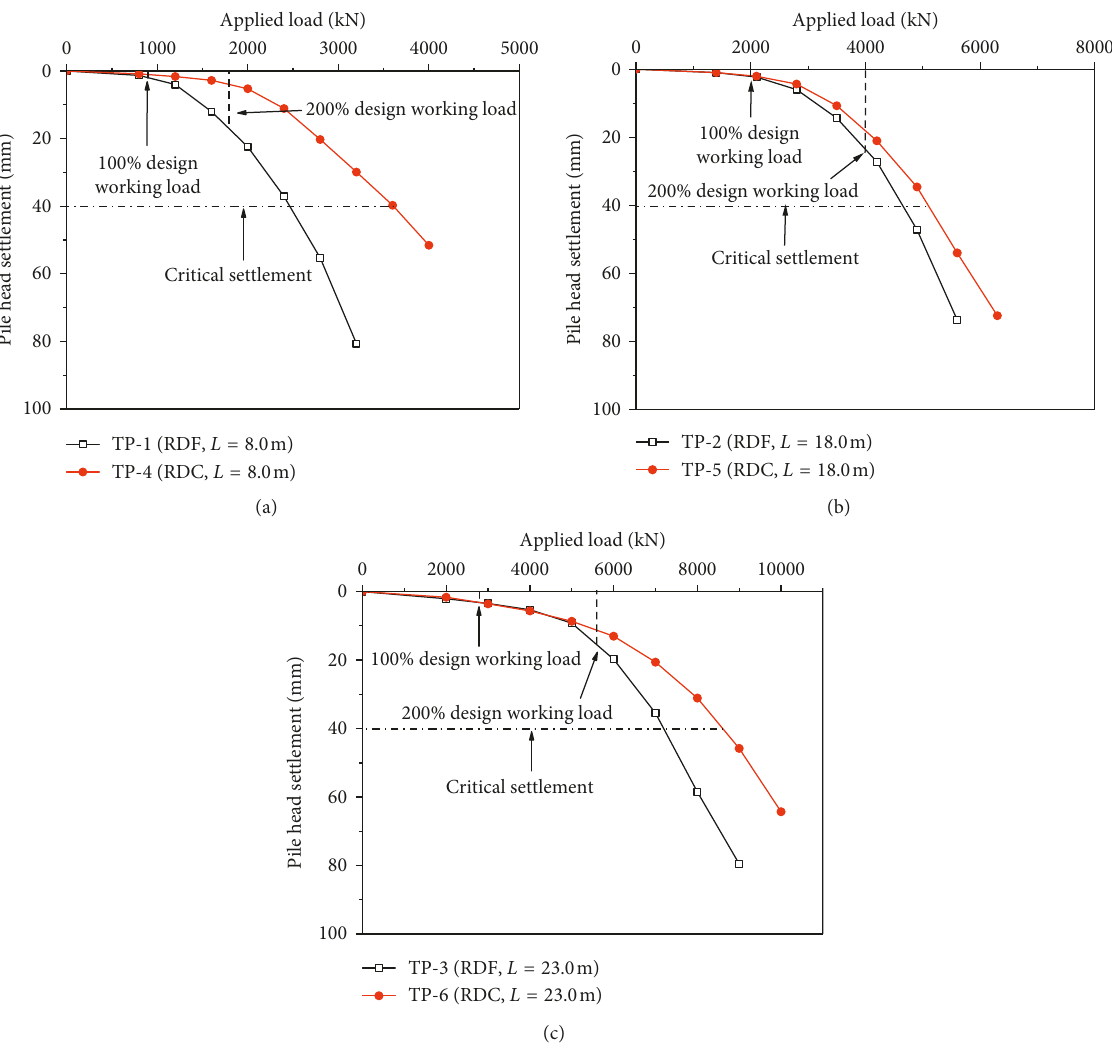
Figure 7: Load-settlement curves for all test piles.